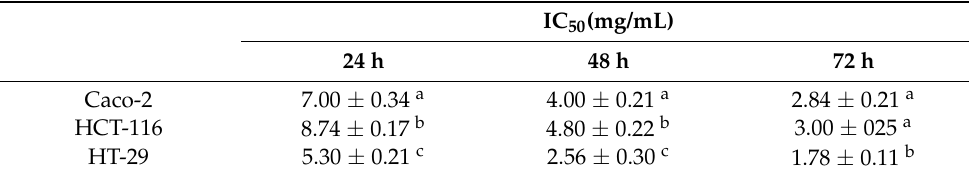
Table 2. IC 50 values of CSO for 24, 48, and 72 h on Caco-2, HCT-116, and HT-29 cells.